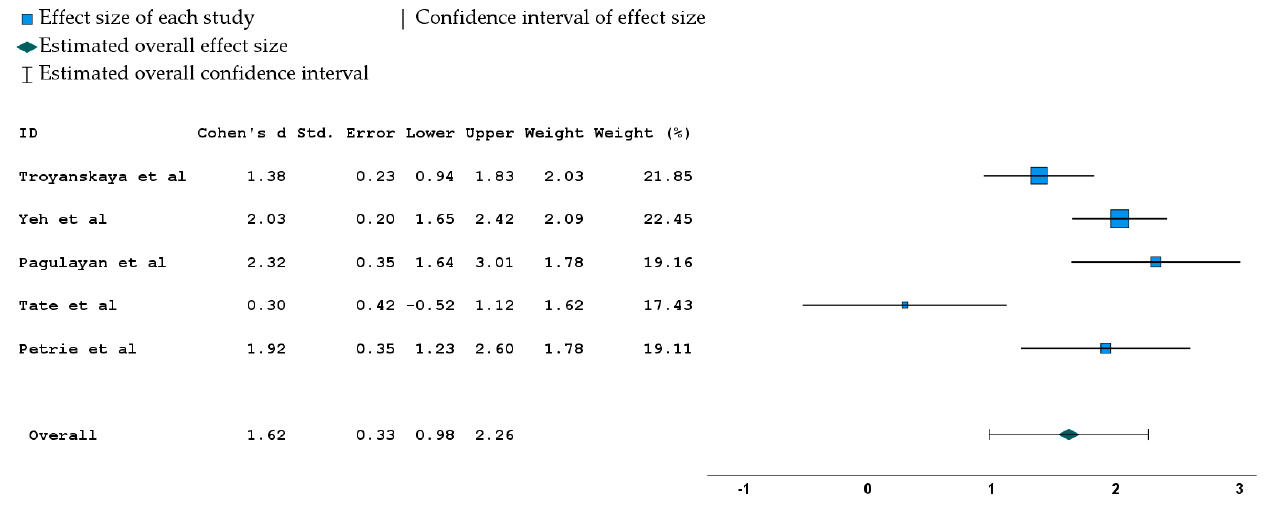
Figure 2. Forest plot showing the summary effect estimates for each paper of blast mTBI and no blast mTBI PCL score